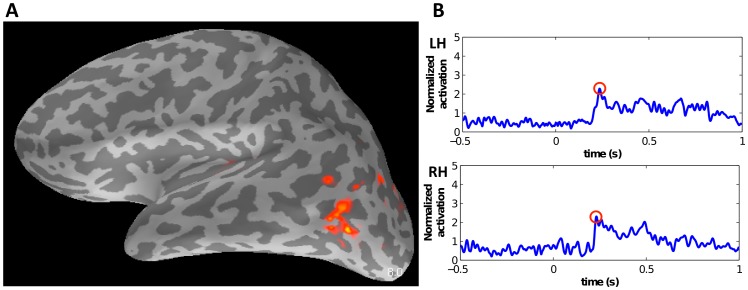
MT+ 230 ms ERF on the cortex.(A) Left hemisphere cortical activation at 230 ms of MT+ area in a representative subject. The activation shown on the inflated brain, in the cortical region, is at least 2.5 SD above noise level. (B) The corresponding time courses of MT+ activation in the same subject (top: left hemisphere; bottom: right hemisphere). The red circle indicates the peak at the 230 ms ERF corresponding to P230.